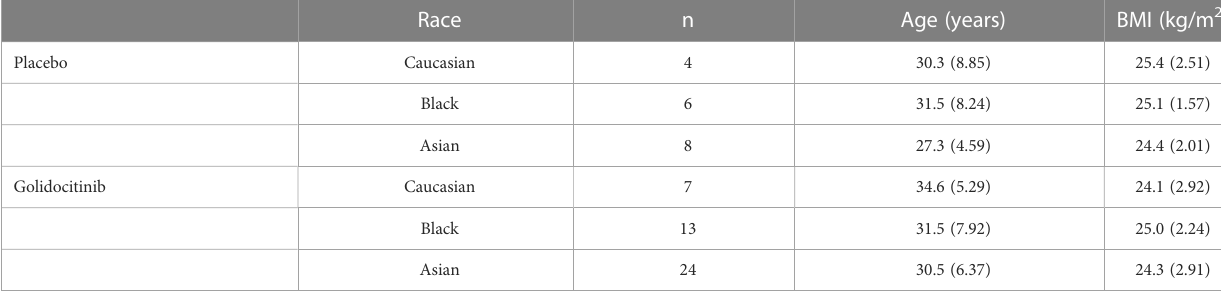
SAD, Single Ascending Dose. Data are presented as arithmetic mean ± standard